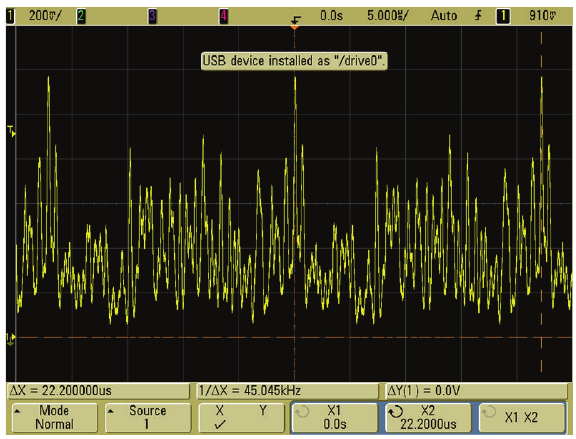
Figure 9: For 5 𝜇 s frequency, 4th degree Chi-square power distri- bution.